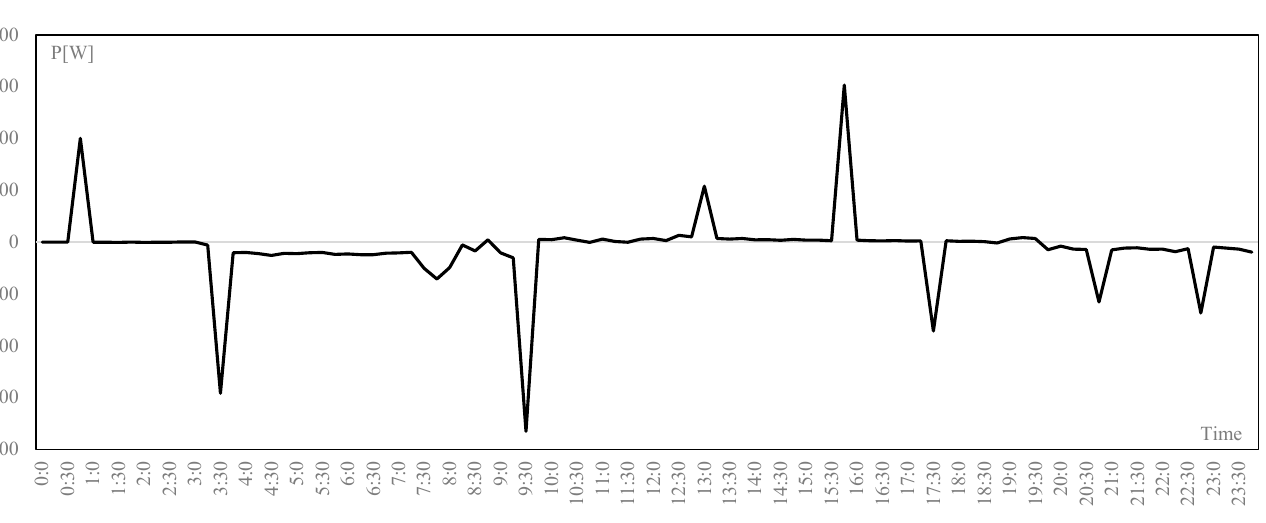
(orange), AEU3 (grey), AEU4 (yellow).